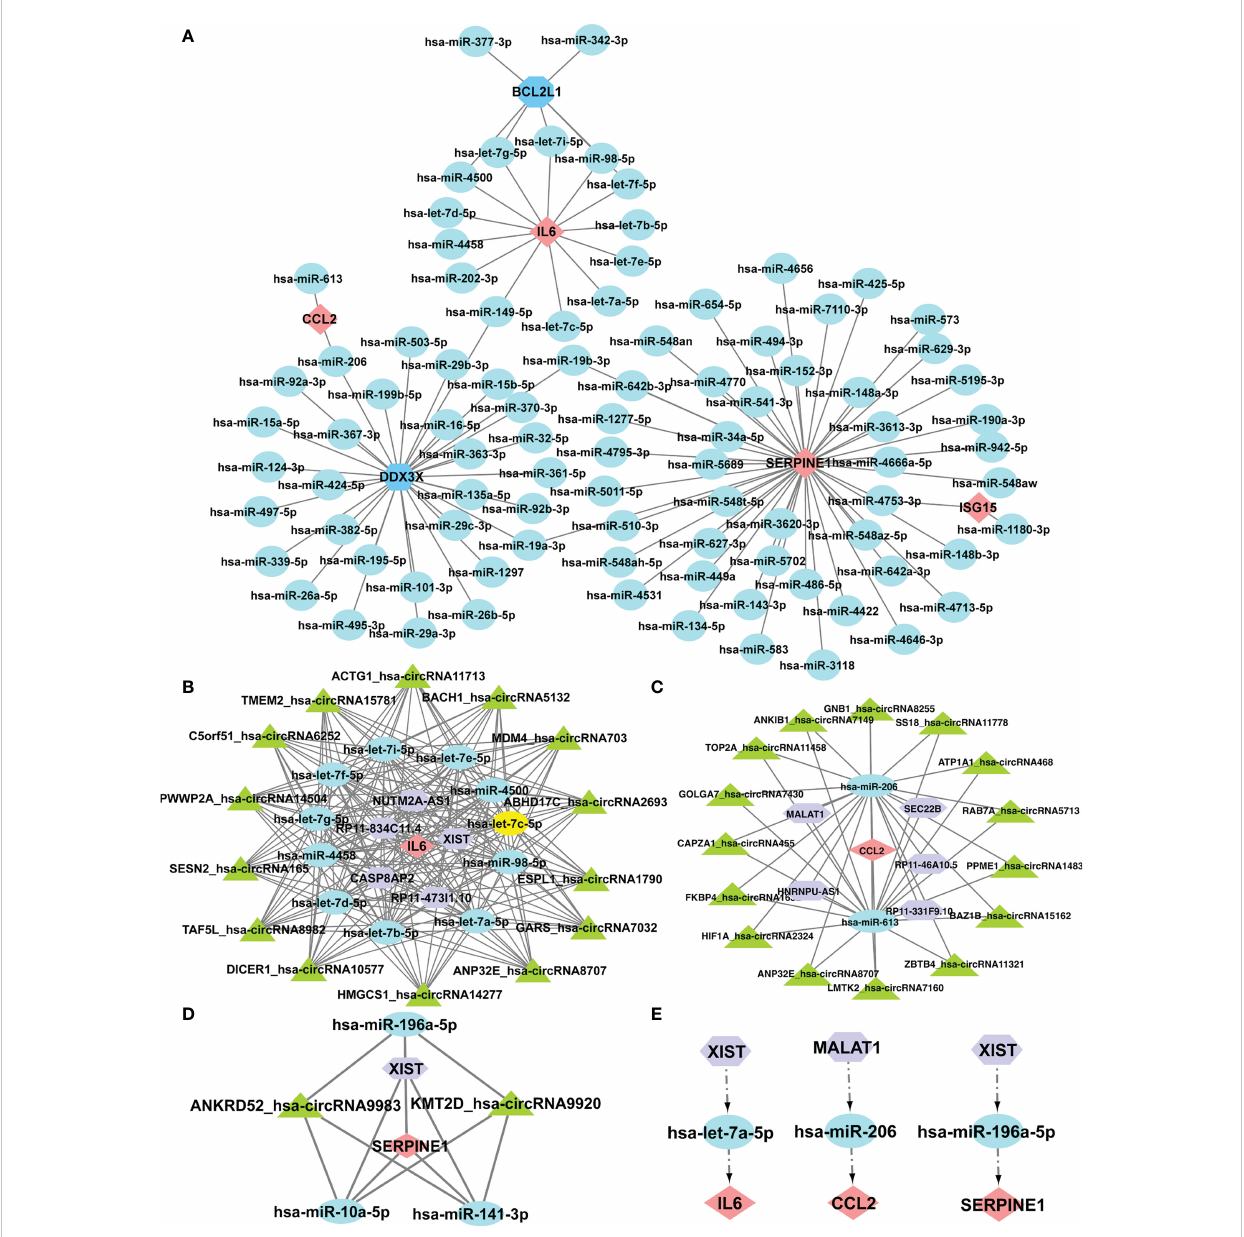
FIGURE 7 Construction of the ceRNA networks of SERPINE1, CCL2, and IL6 and the potential RNA regulatory pathways. (A) Cytoscape created the mRNA- miRNA co-expressed network. SERPINE1 has the most target miRNAs. One node represents an mRNA or miRNA, while one edge represents one interaction between mRNA and miRNA. Pink diamonds and blue octagons represent the hub genes, and blue circles represent miRNAs. The prognostic circRNA-lncRNA-miRNA-mRNA ceRNA network was constructed, including three subnetworks. (B) ceRNA network of IL6. (C) ceRNA network of CCl2. (D) ceRNA network of SERPINE1. (E) XIST1-let-7a-5p-IL6, MALAT1-miR-206-CCL2, and XIST1-miR-196a-5p-SERPINE1. Pink diamonds represent the hub genes; blue circles represent miRNAs; a purple octagon represents lncRNAs; and a green triangle represents